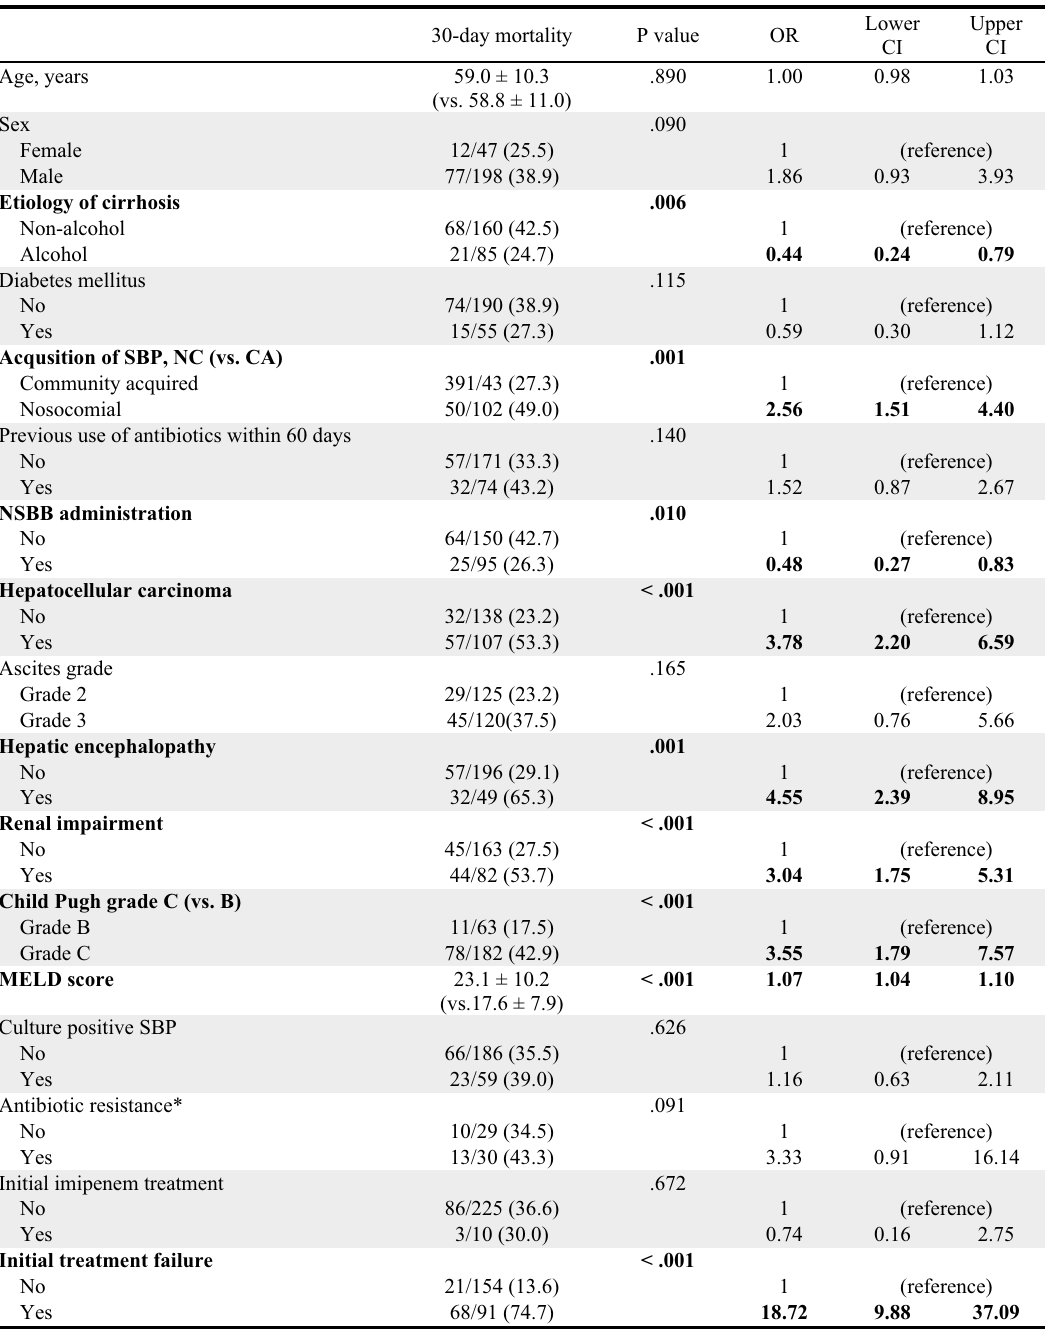
Table 5. Factors associated with 30-day mortality (Univariate analysis). CRP C-reactive protein, GI Gasointestinal, MELD Model for end stage liver disease, PMNLs Polymorphonuclear leukocytes, SBP Spontaneous bacterial peritonitis, WBC White blood cells. Antibiotic resistance* includes resistance to one of cefotaxime, ciprofloxacin, vancomycin, and ESBL( +). Significant values are in